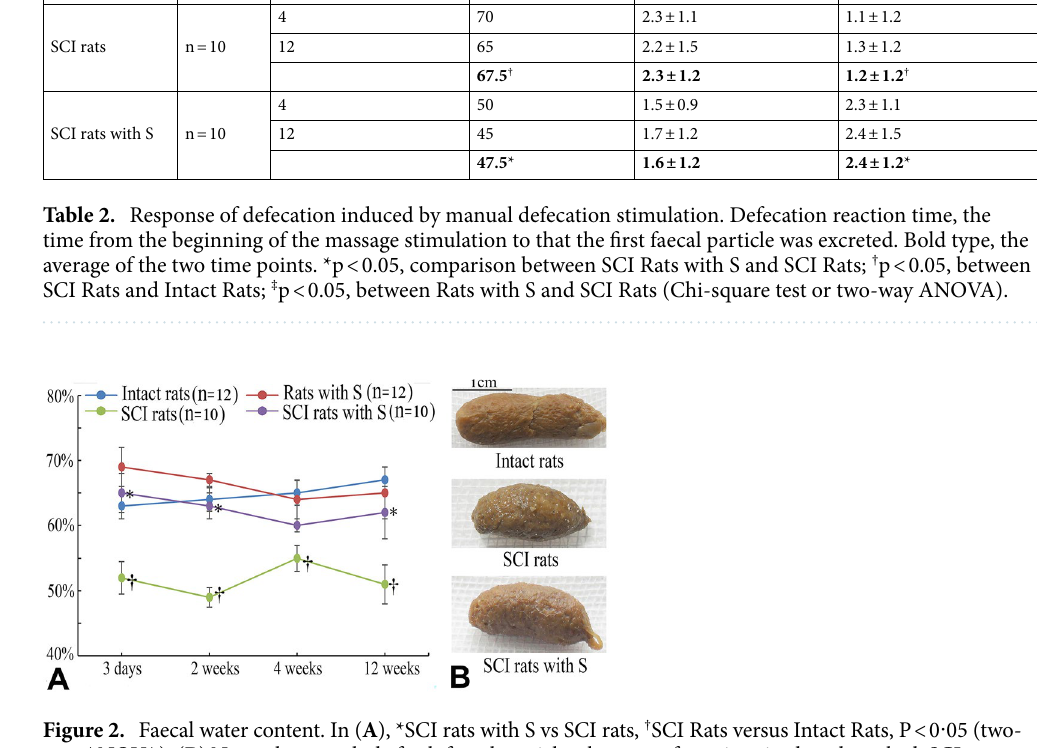
Figure 2. Faecal water content. In ( A ), *SCI rats with S vs SCI rats, † SCI Rats versus Intact Rats, P < 0 ⋅ 05 (two- way ANOVA). ( B ) Normal rats exclude fresh faecal particles that are soft, moisturized, and cracked. SCI rats exclude fresh faeces that are hard and firm and have a tight surface